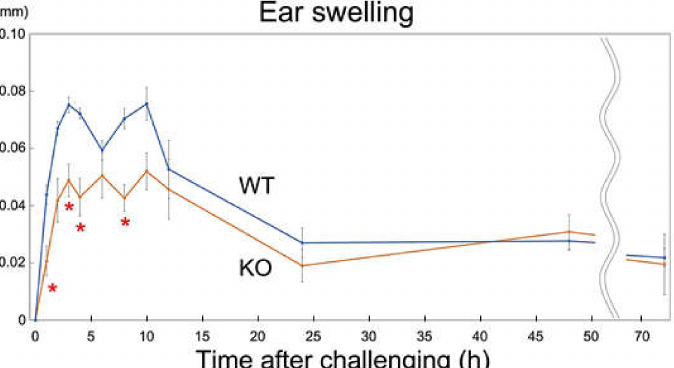
Figure 5. Ear swelling of mice in response to nickel solution. Wild-type (WT) and Rab44-knockout (KO) mice were sensitized with LPS and a nickel solution. Ten days after sensitization, the mice were fed with nickel-water for 2 months. Two months later, the mice were injected with the nickel solution. Ear thickness was measured before the stimulation and for 72 h after the stimulation. * p < 0.05 compared to WT.